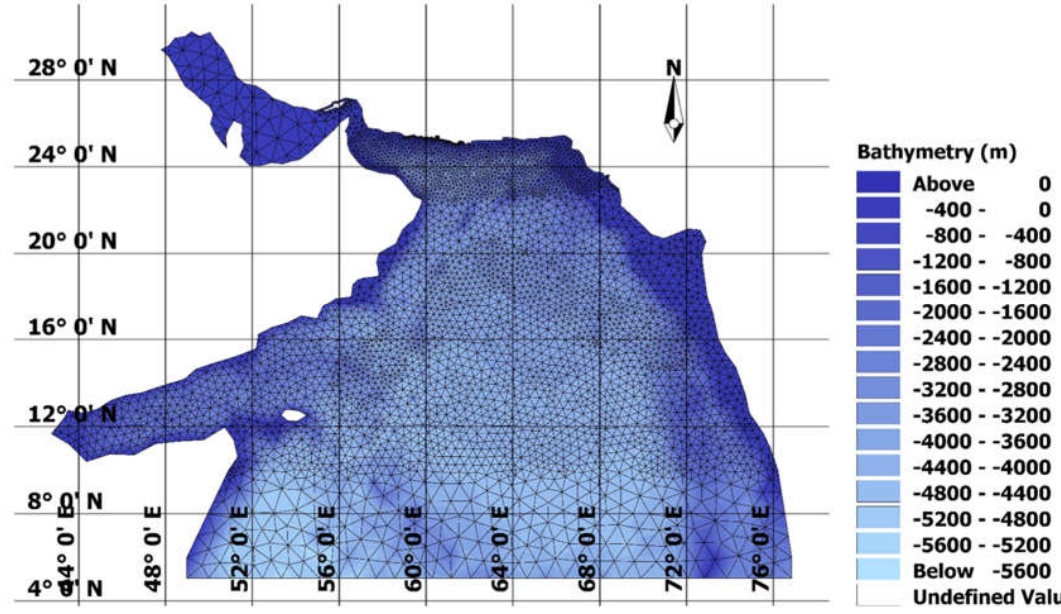
Figure 5. Computational domain and bathymetry.